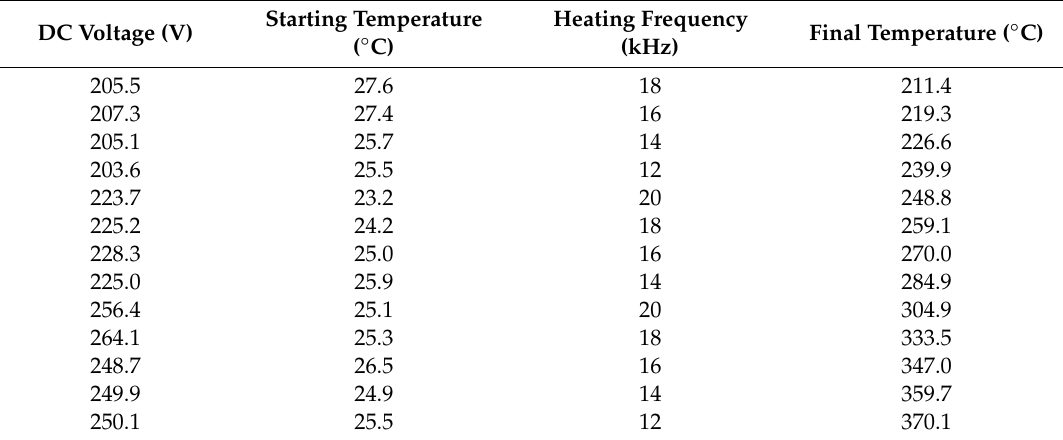
Table 3. Experimental results of BT40-SF10 tool